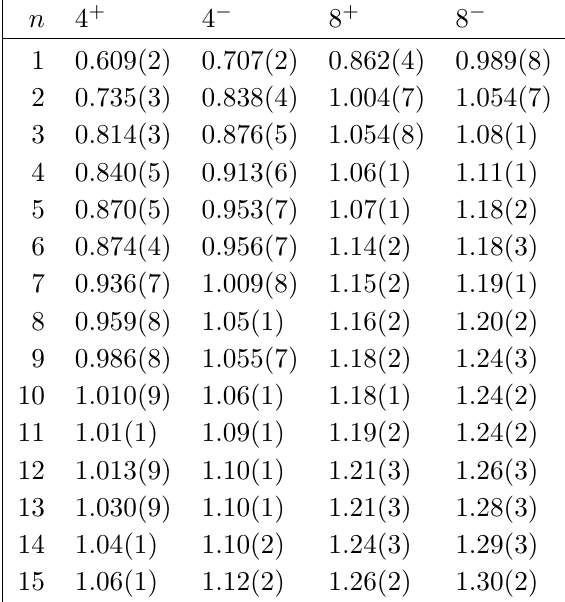
Table 7. Masses for glueballs within A 1 and A 2 representation of Z 4 with J > 0 averaged over P .